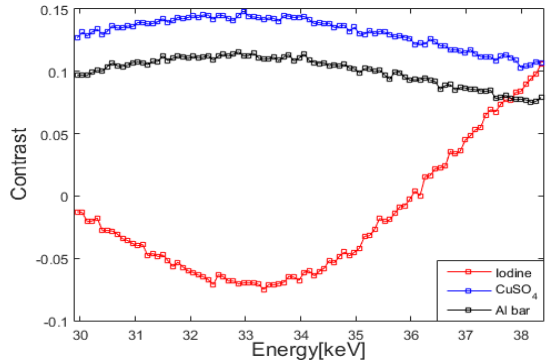
Figure 8. The derivatives of the projection images at the regions of iodine, CuSO 4 , and aluminum.